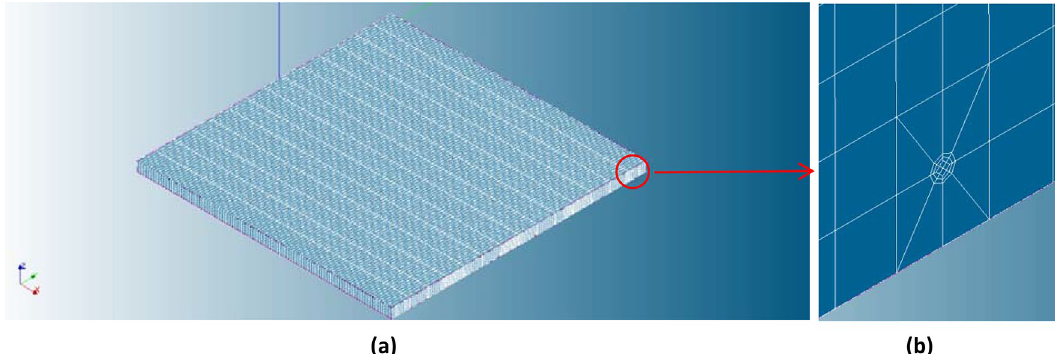
Fig. 8 Mesh of entire panel ( a ) and a detail of the wire mesh ( b )